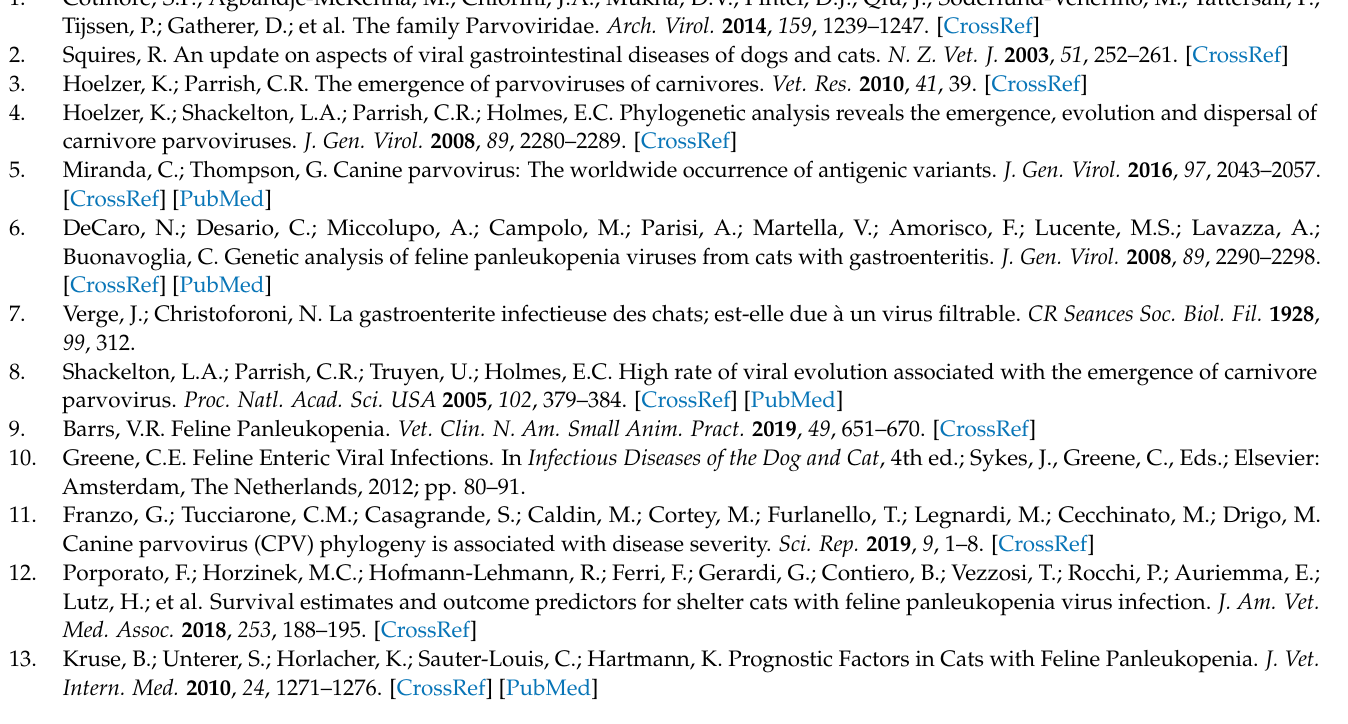
indicating branch support; Figure S2: FPV migration paths in Italy; Table S1 Accession numbers of sequences in the international database, Table S2 List of clinical variables considered in the study, Table S3 Summary of variable statistical association with phylogenetic